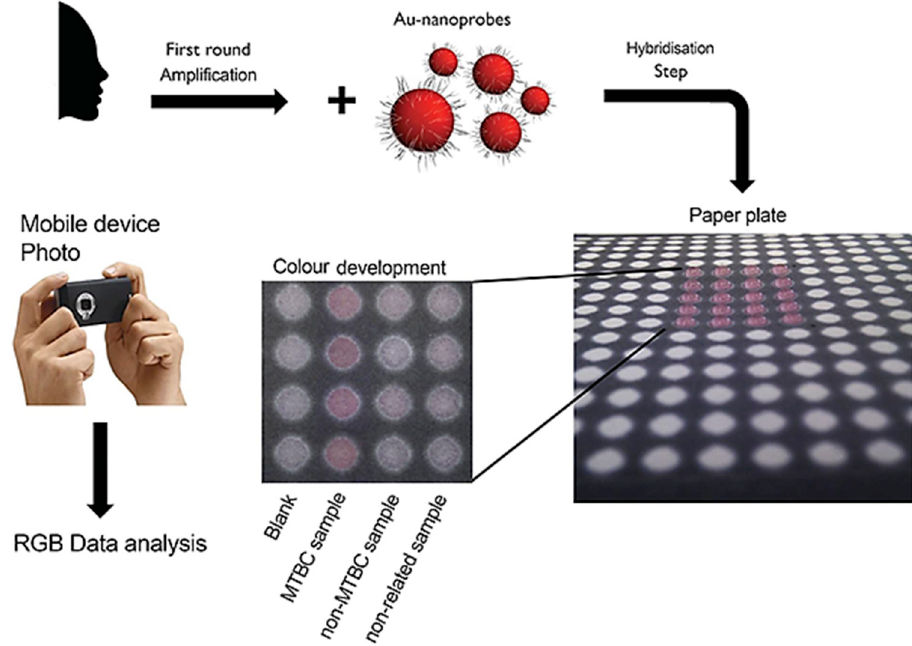
Figure 8. Au-Nanoprobe strategy for the detection of MTBC members. Schematic representation of the detection with gold nanoprobes. The colorimetric assay consists of visual comparisons of test solutions after salt induced Au-nanoprobe aggregation on a MgCl 2 impregnated paper plate: MTBC Au-nanoprobe alone (blank); MTBC Au-nanoprobe in the presence of MTBC sample ( M. tuberculosis ); MTBC Au-nanoprobe in the presence of a non-MTBC sample; and MTBC Au-nanoprobe in the presence of a non-complementary sample (non-related). After color development a photo of the paper plate was captured and RGB image analysis was performed. Adapted from [61]